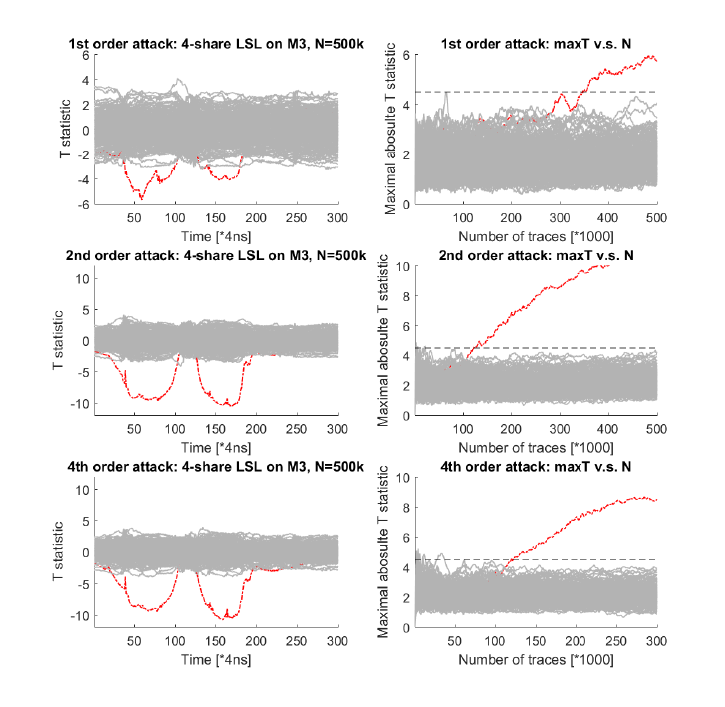
Figure 10: Attacking the 4-share version on M3: each trace repeat 1000